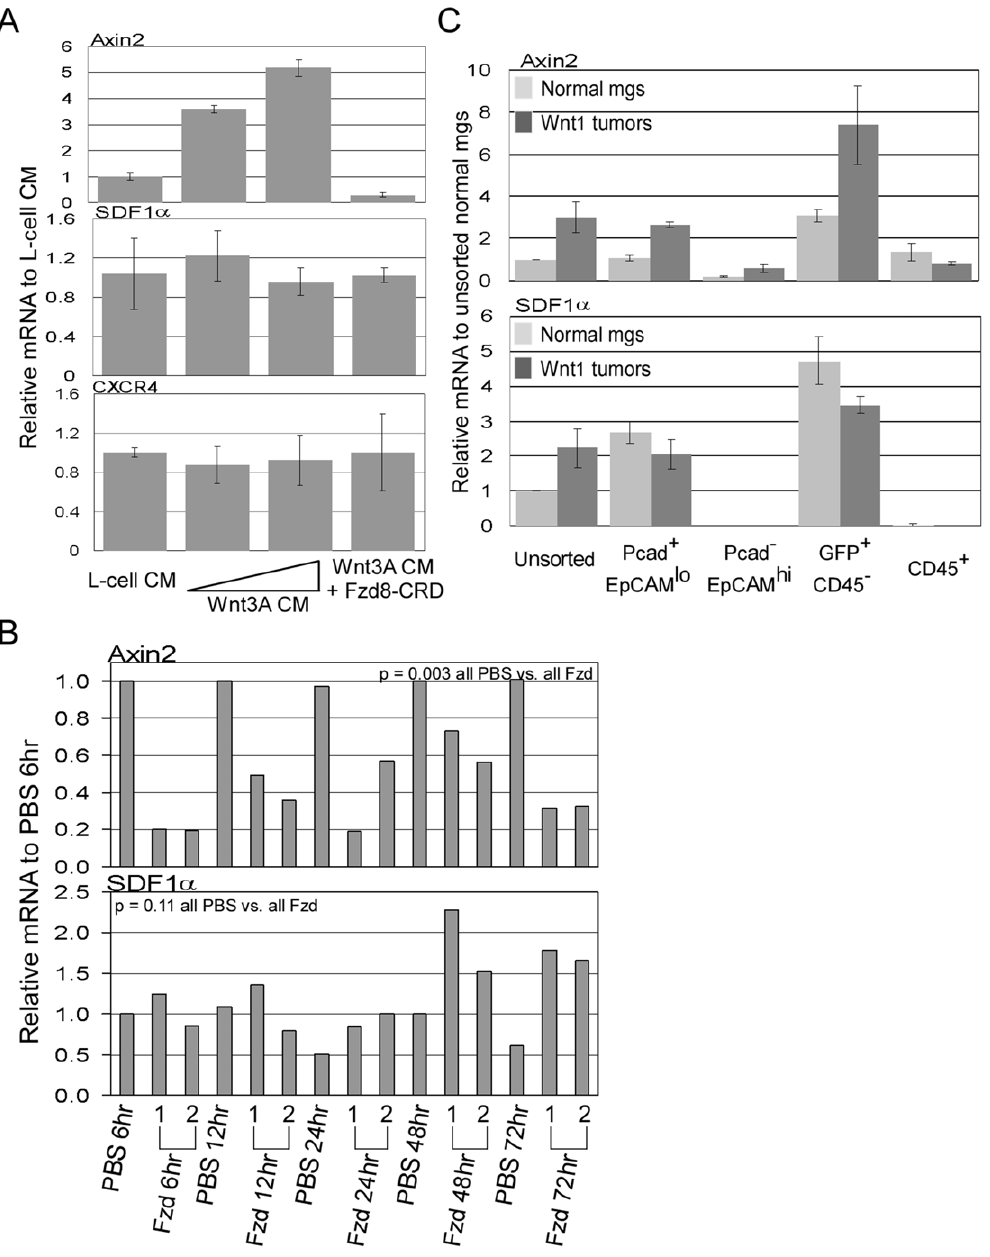
Figure 3. Determination of whether SDF1 is a Wnt signaling responsive gene. A, qRT-PCR analysis of axin2, SDF1 a , and CXCR4 transcript levels in normal mammary epithelial cells cultured in Wnt3A conditioned media. Triplicate plated cells were cultured in control L-cell media:mammary epithelial cell culture media (1:1 dilution), in Wnt3A conditioned media (1:2 or 1:1 dilution), and in Wnt3A conditioned media (1:1) + Fzd8-CRD (10 m g/ mL). Relative transcript levels were normalized to levels in L-cell media. Error bars represent standard deviations derived from triplicate plated cells. B, qRT-PCR analysis of axin2 and SDF1 a transcript levels in Wnt1 tumors taken from tumor-bearing mice that were treated with Fzd8-CRD at various hours of post injection. Each time points contain samples from two independently FzD8-CRD treated mice numbered 1 and 2. Relative transcript levels were normalized to the level in the 6 hour PBS-treated tumor sample. C , qRT-PCR analysis of axin2 and SDF1 a transcript levels in the sorted cell populations from Wnt1 tumors (dark bars) or from normal mammary glands (light bars). Cell populations were isolated from three independent Wnt1 tumors or from three independent pools of normal mammary glands (pools of glands from , 20 female C57BL6 mice). Error bars represent standard deviations derived from the three independent tumors or pools of mammary gland sorts.